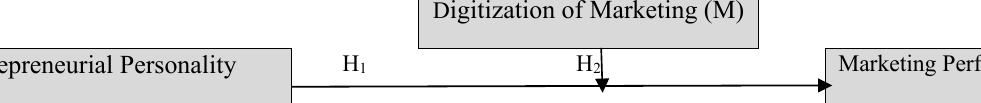
Fig. 1. Research Conceptual